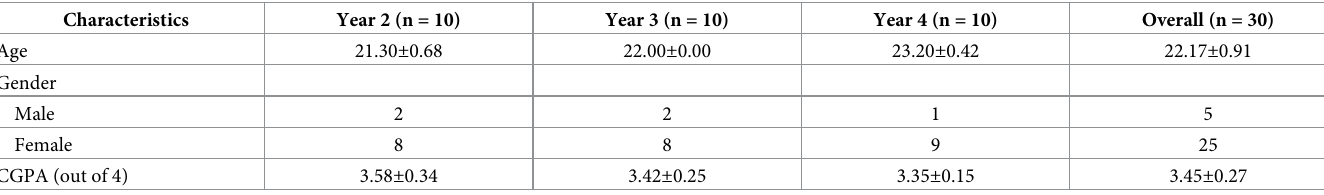
cant difference in the VCDR uncertainty range between the three groups (one-way ANOVA [F(2,27) = 0.121, p = 0.887]). The percentage of correctly estimating a test photo with VCDR of 0.53 indicated the ability of the participants to discriminate VCDR that was 0.10 units larger than the standard photo’s VCDR (0.43). The mean percentage correct 0.53 VCDR estimation for participants in Year 2, 3, and 4 were 73.72% ± 11.61, 77.52% ± 14.23 and 79.56% ± 6.80, respectively. Although trainees with the most clinical experience (Year 4) tend to have higher percentages in judging the Table 1. Participants’ sociodemographics and cumulative grade point average (CGPA).